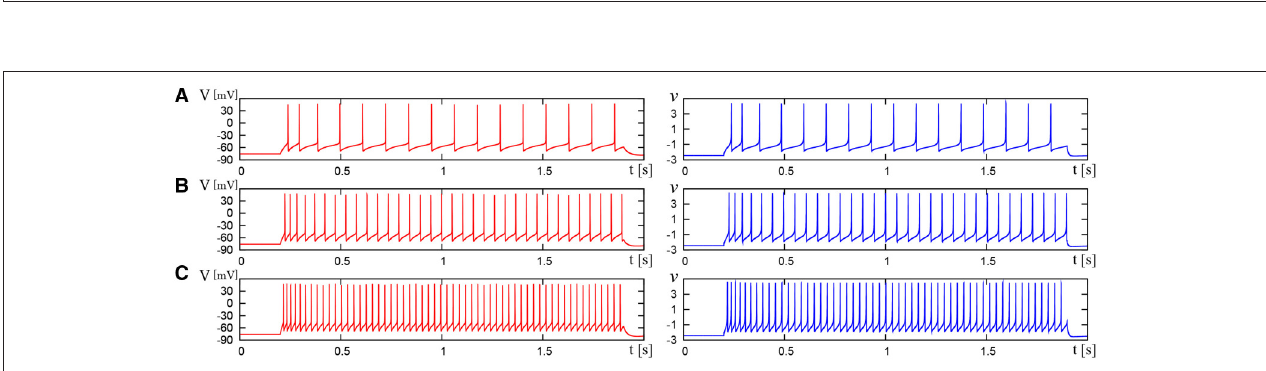
FIGURE 7 | Waveforms of Pospischil and DSSN models, corresponding to an excitatory neuron in the RS class. The Pospischils’ model (left) generates periodic spikes in response to a step input rising at t = 0.2 where I stim is (A) 1.1, (B) 1.5, (C) 2.1 nA. The DSSN model (right) generates periodic spikes in response to a step input rising at t = 0.2 where I stim is (A) 2.9221, (B) 3.2521, (C) 3.7921.